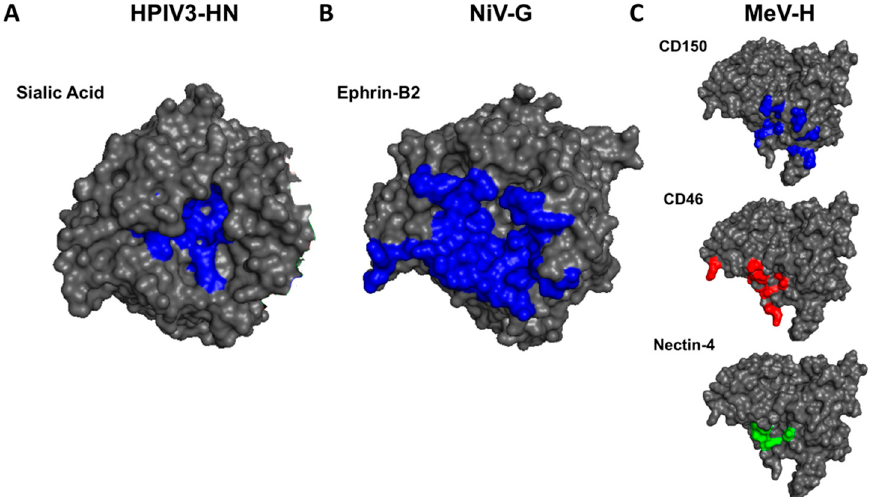
Figure 3. Receptor binding on MeV-H occurs on a di ff erent face of the β -propeller, as compared to the receptor binding sites on HPIV3-HN and NiV-G. Surface representations of HPIV3-HN, NiV-G, and MeV-H (PDB accession no. 1V3C, 3D11, 2RKC, respectively) are depicted with the monomeric head shown such that the center of the six-bladed β -propeller is pointing towards the reader. ( A ) Sialic acid binding residues on HPIV3-HN and ( B ) Ephrin-B2 binding residues on NiV-G are highlighted in blue. ( C ) top, CD150 binding residues on MeV-H are highlighted in blue; center, CD46 binding residues in red; bottom, Nectin-4 binding residues in green. The ligand-interface areas were determined by PDBePISA server [81] .